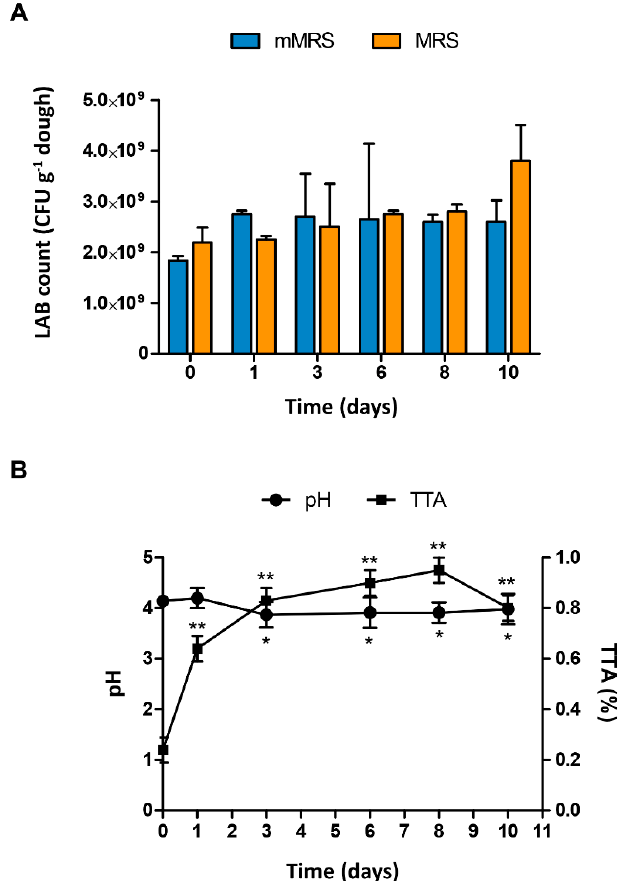
Figure 1. ( A ) Counts of lactic acid bacteria (LAB) in De Man, Rogosa, Sharpe (MRS) and modified MRS (mMRS) during spontaneous fermentation of sorghum flour sourdoughs for 10 days. ( B ) Total titratable acidity (TTA) values during spontaneous fermentation. One-way ANOVA analysis followed by a Tukey’s test was made to compare all the values to the ones of time 0; asterisks indicate significant ( p < 0.05) differences.